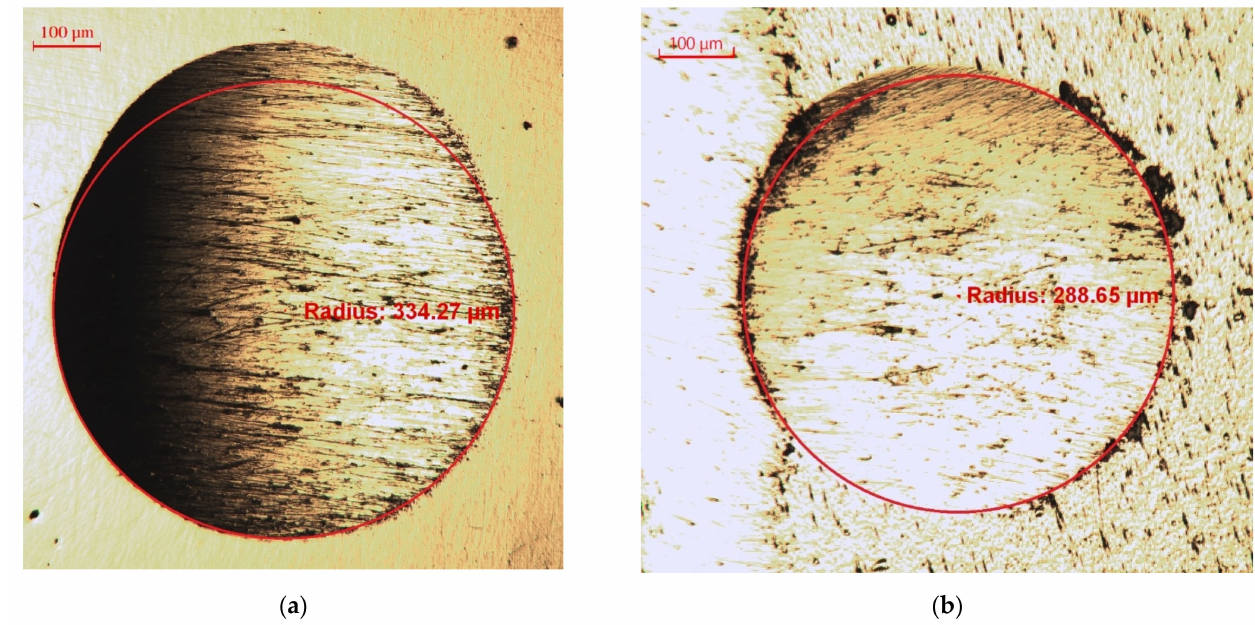
Figure 8. The wear crater of ( a ) N-H and ( b ) N-H-PN test samples.